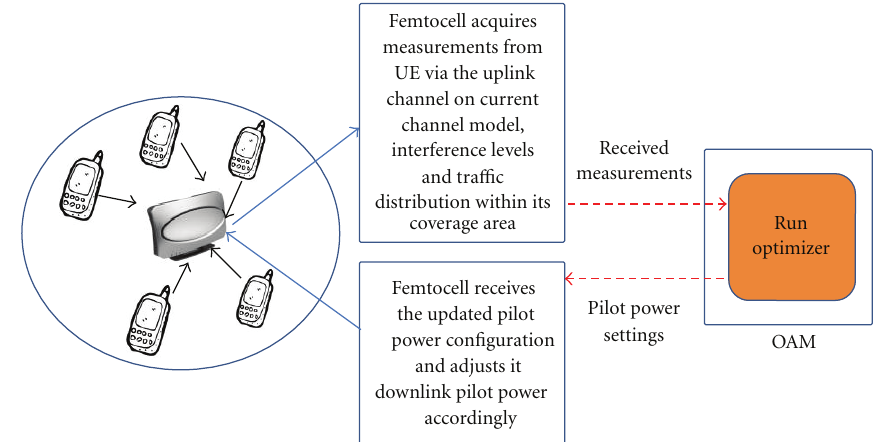
Figure 4: Self-optimization of pilot power